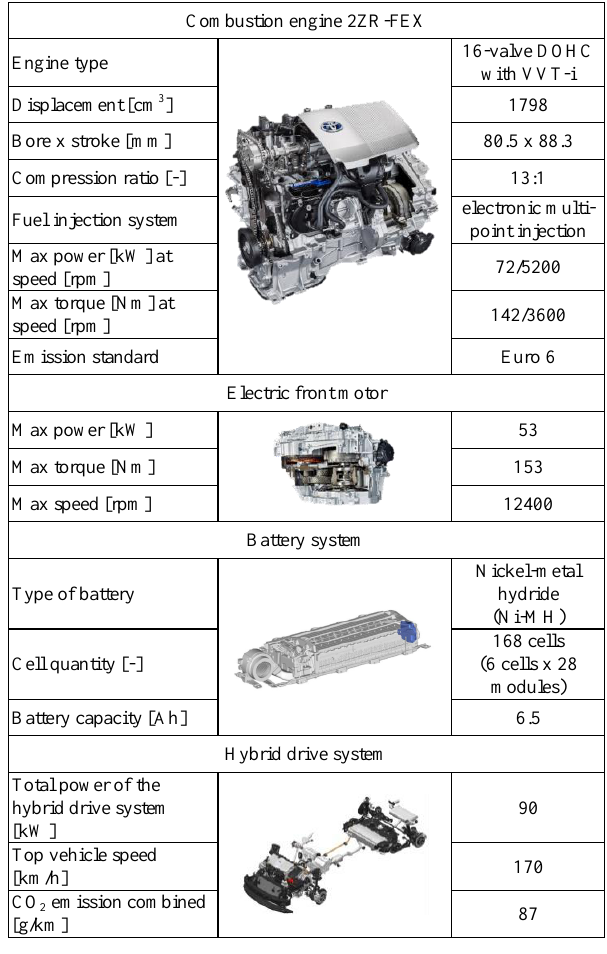
Table 1. Test vehicle technical data